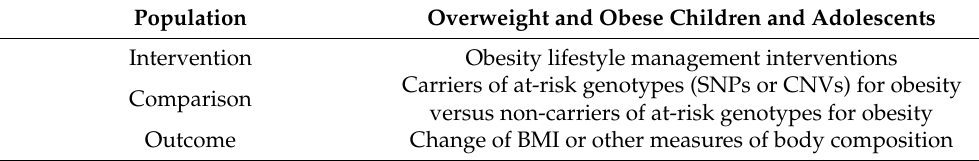
Table 1. PICO Model. Population Overweight and Obese Children and Adolescents Intervention Obesity lifestyle management interventions Carriers of at-risk genotypes (SNPs or CNVs) for obesity Comparison versus non-carriers of at-risk genotypes for obesity Outcome Change of BMI or other measures of body